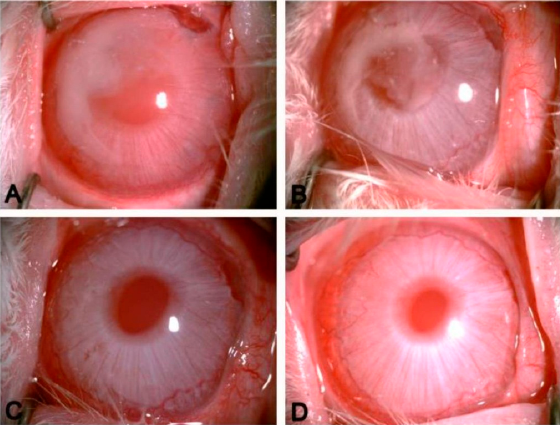
Figure 4. In vivo gel formation of PECE hydrogel in the anterior chamber of rabbit. PECE was absorbed completely within three weeks. ( A ) 1 day after injection; ( B ) 7 days after injection; ( C ) 14 days after injection; ( D ) 21 days after injection (×40 magnification) [227].